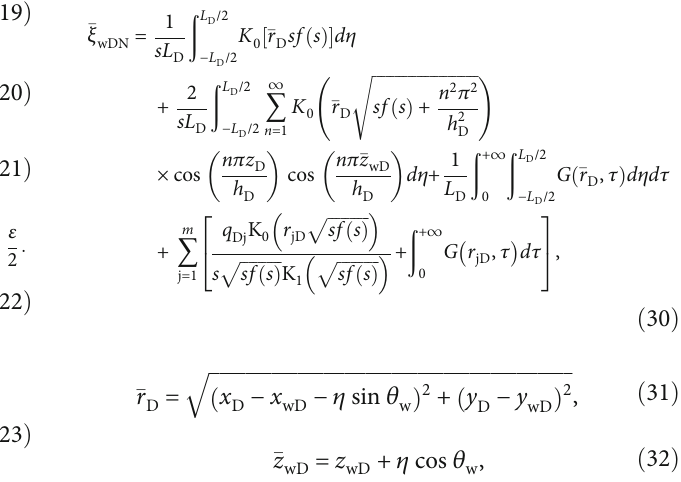
p(cid:10) ffiffiffiffiffiffiffiffiffiffi p ffiffiffiffiffiffiffiffiffiffi s sf s ð Þ K sf s ð Þ 1